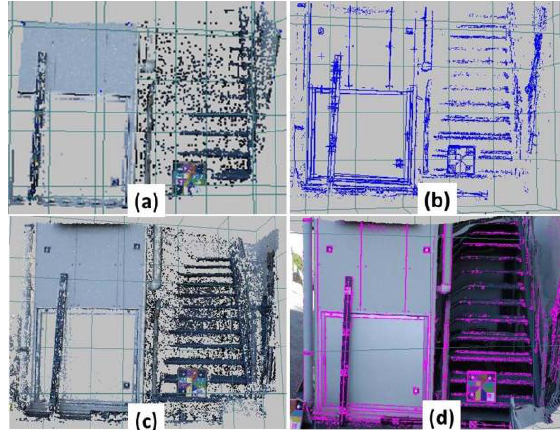
Figure 9. Matching Result (a) Only TIN-LSM method. (b) Edge-Matching (3D Edge). (c) Edge Surface-Matching. (d) Superposition of 3D Edge onto the texture-mapped Edge Surface-Matching result